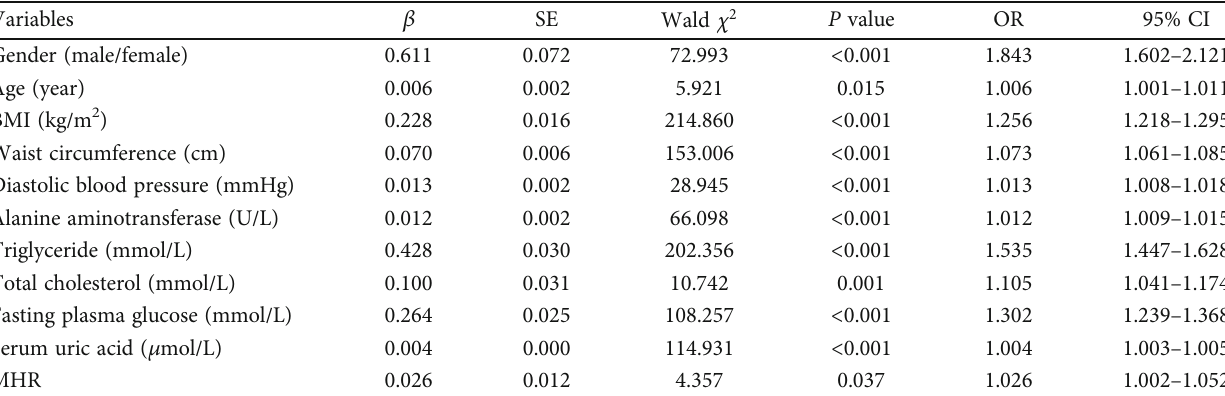
Table 5: Multivariable analysis for factors associated with